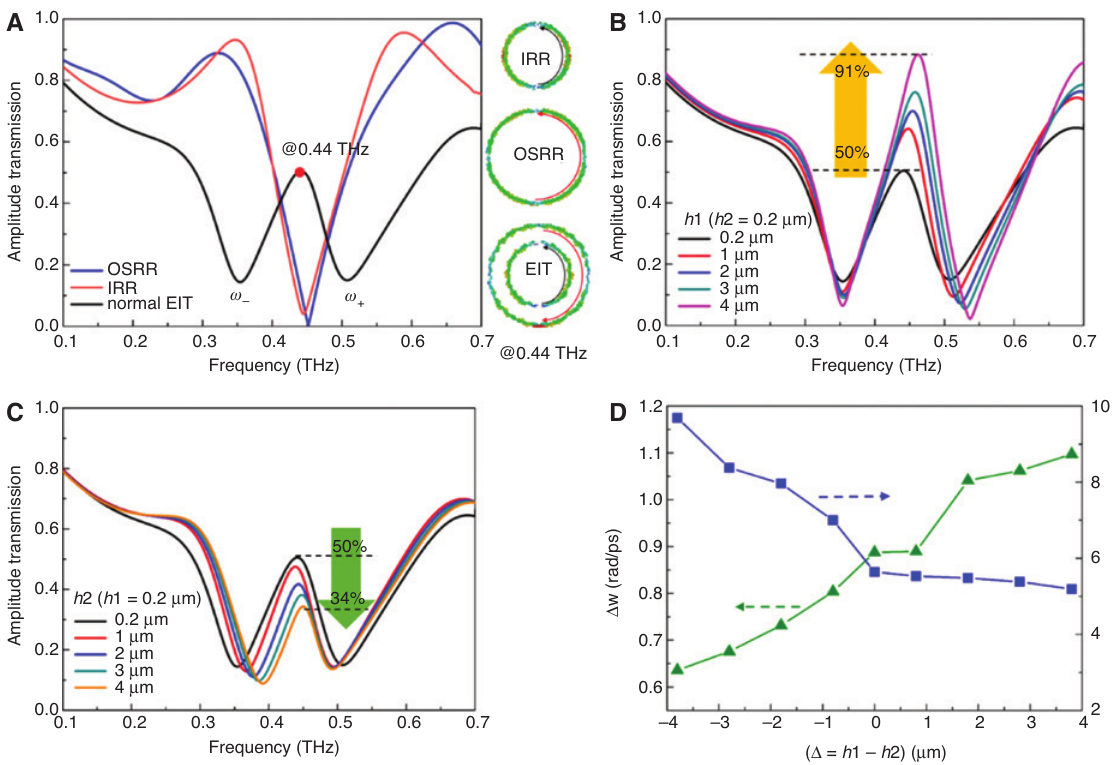
Figure 2: Simulation results of the undulated meta-surface. (A) Transmission spectra and current distribution of the sole IRR, the sole OSRR and the combined structure. Simulation results of the transmission spectrum for the various heights of the IRR (B) and OSRR (C), respectively. (D) Linewidth and Q factor with different height differences Δ